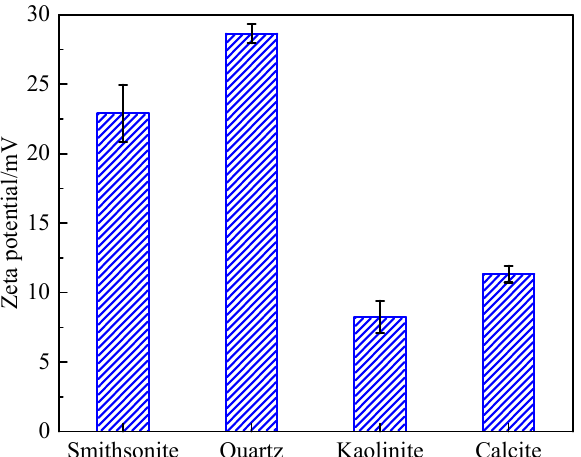
Figure 10. Zeta potential of smithsonite, quartz, kaolinite, and calcite in the presence of 150 mg/L octadecylamine at pH 9.5.